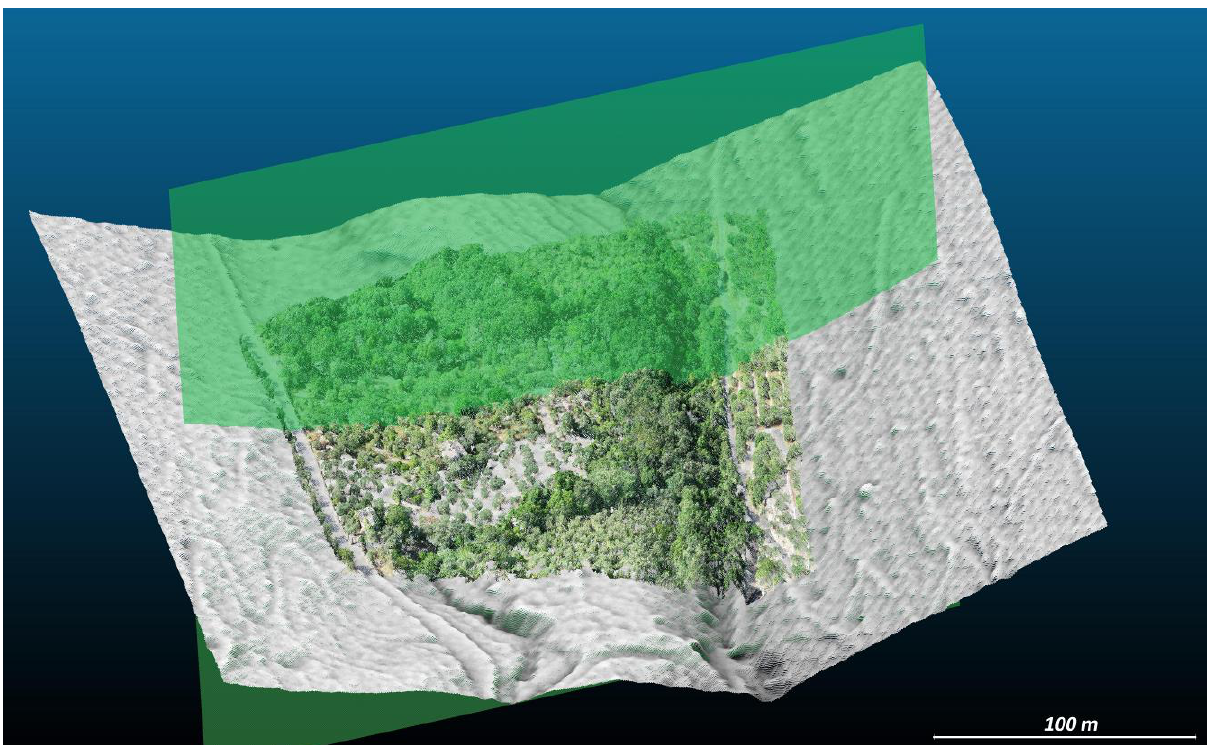
Figure 7 – One of the slide planes used to investigate the cave